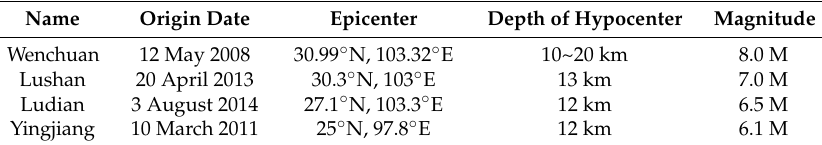
Table 2. Key parameters of the earthquakes involved in this study.